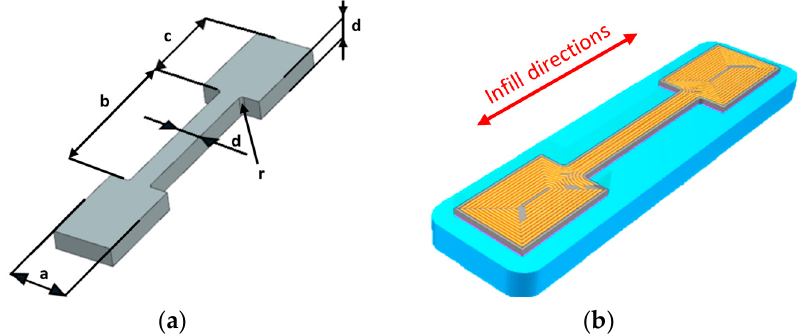
Table 1. Chemical composition (wt.%) of the considered 17-4 PH stainless steel.